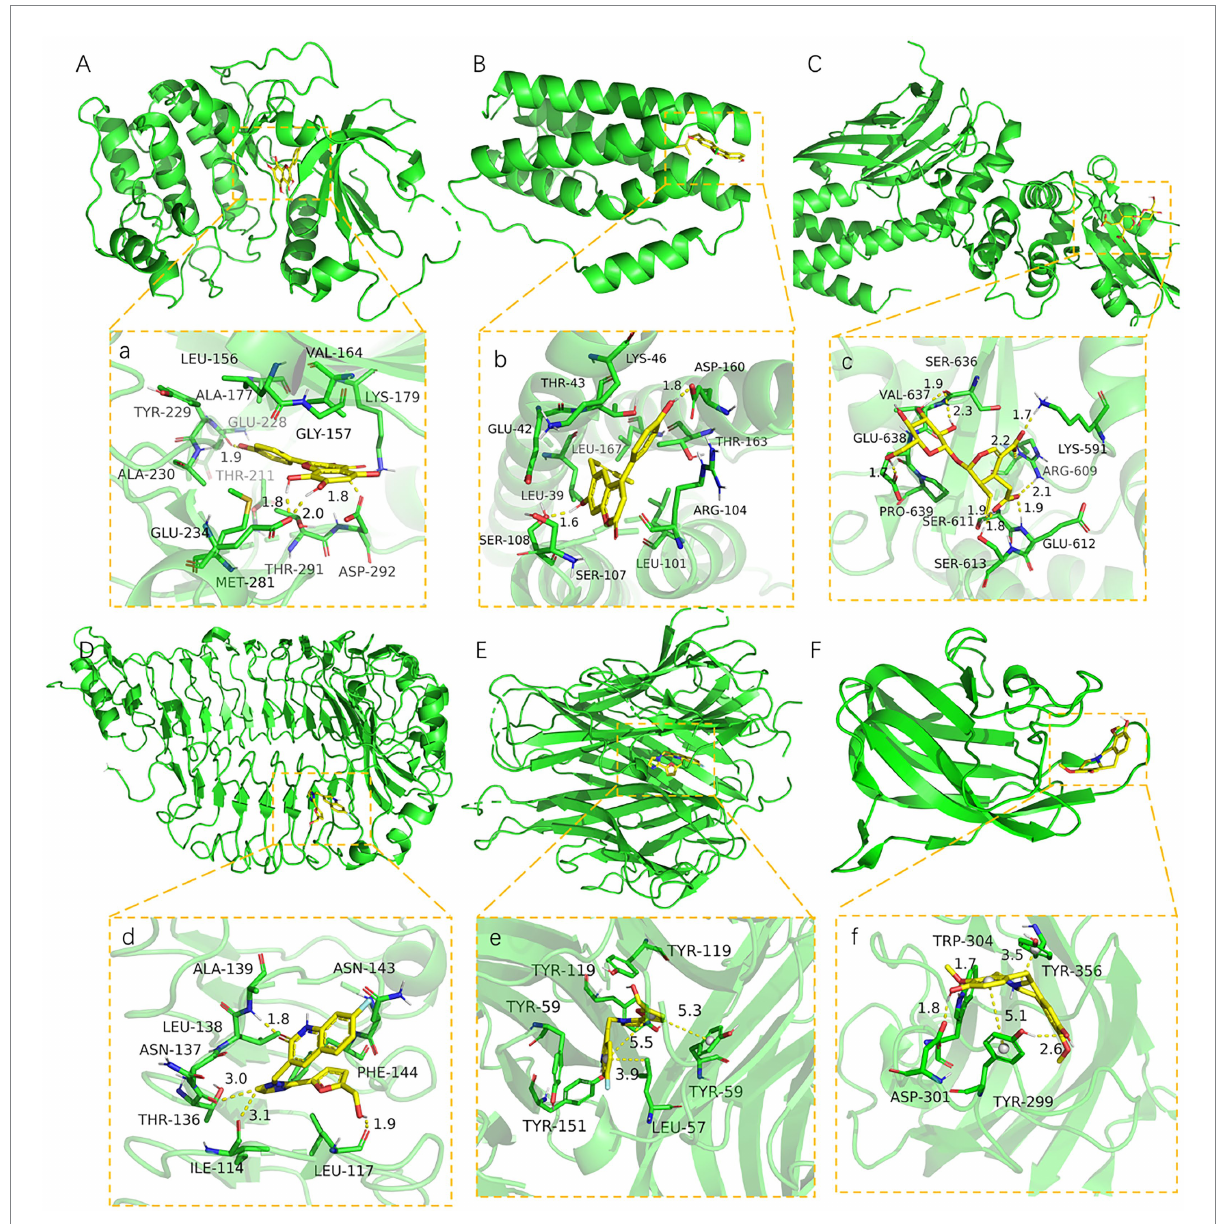
FIGURE 6 The binding site of target with compound (A-F) . The 3D structure of AKT1-ligand063, IL6-ligand121, STAT3-ligand113, TLR4-ligand103, TNF- ligand103, VEGFA-ligand073. (a-f) A close view of the active site binding with AKT1-ligand063, IL6-ligand121, STAT3-ligand113, TLR4-ligand103, TNF-ligand103, VEGFA-ligand073. Key residues interacting with ligands were shown as sticks and colored green. The protein backbone was shown as a tube and colored bright